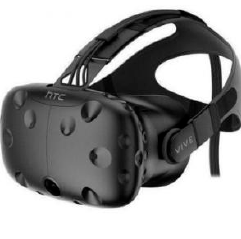
Figure 8. SPIDAR-based interaction system. Reproduced with permission from [113], Springer Nature, 2010.